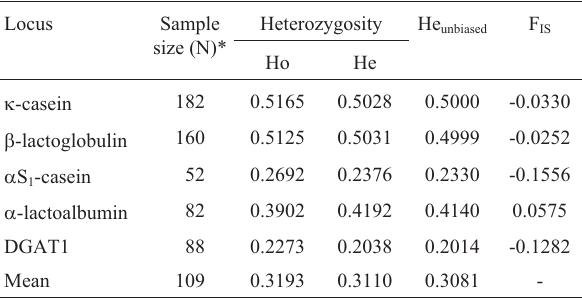
Table 2 - Heterozygosity (observed, Ho; expected, He; and unbiased, He unbiased ) and Wright’s fixation index (F IS ) for the milk protein genes ( (cid:2) -casein , (cid:3) -lactoglobulin , (cid:4) S 1 -casein , (cid:4) -lactoalbumin ) and the acyl- CoA:diacylglycerol acyltransferase ( DGAT1 )